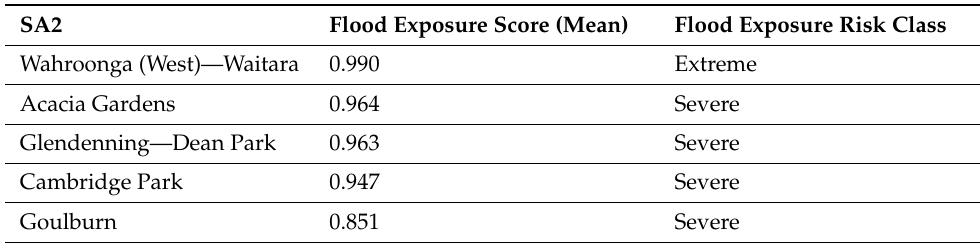
Table 3. SA2s in the Hawkesbury-Nepean Catchment which are severely and extremely exposed to inland